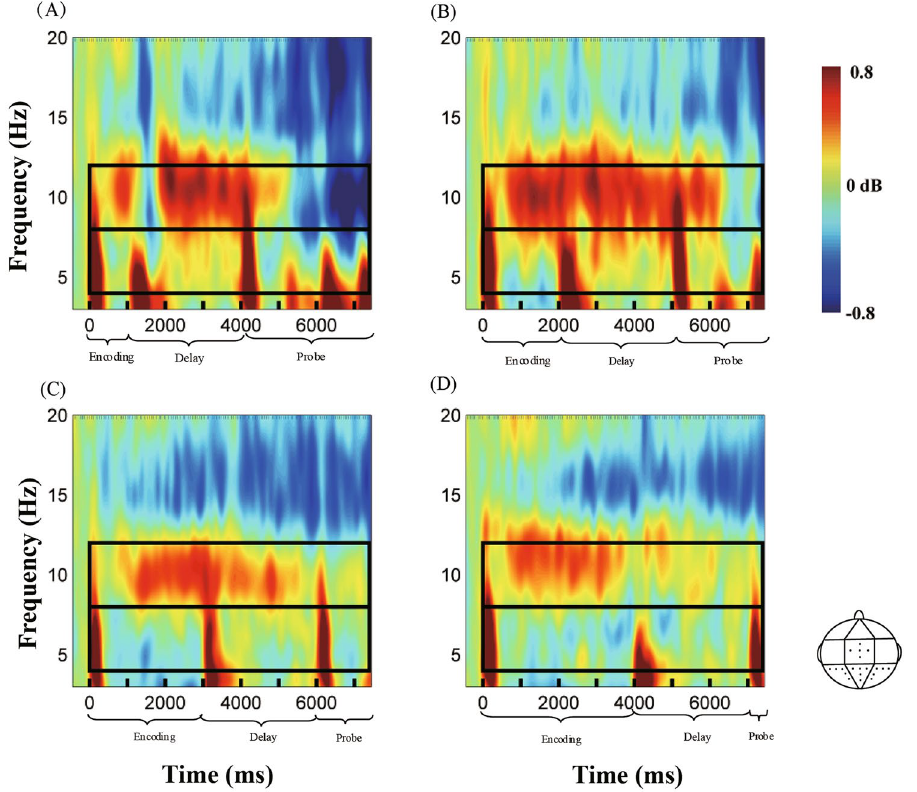
Figure 2. Theta and alpha effects for the whole epoch in the posterior parietal in the 1-s ( A ), 2-s ( B ), 3-s ( C ), and 4-s ( D ) auditory duration conditions. The decibel-transformed value is relative to the baseline interval ( − 0.4 s to − 0.1 s) before the sample stimulus. The theta band is enhanced at the onset and offset of stimuli, whereas the alpha band is enhanced during encoding, especially in the delay